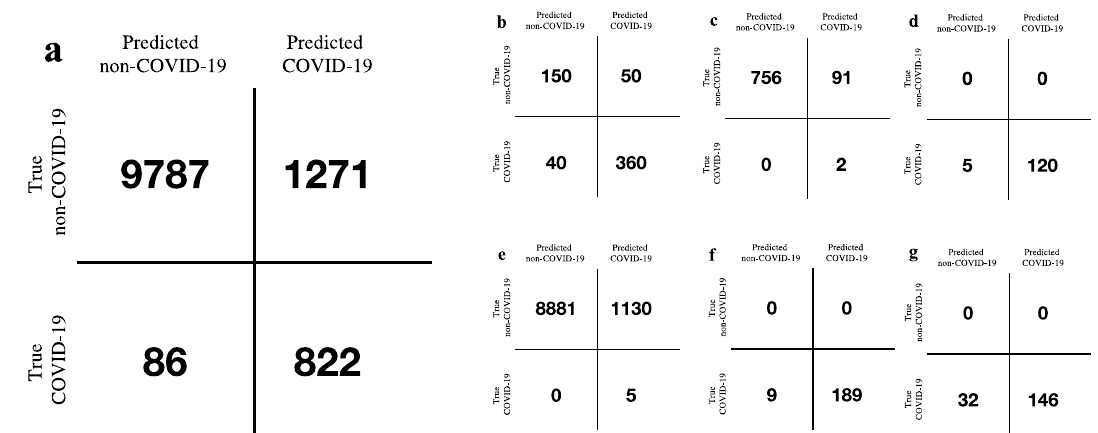
Figure 4. The performance of COVIDNet in the real-world application. ( a ) The confusion matrix of COVIDNet in the 6 hospitals, ( b – g ) the confusion matrix of COVIDNet in each hospital ( b – g represents Hospital 1–6,